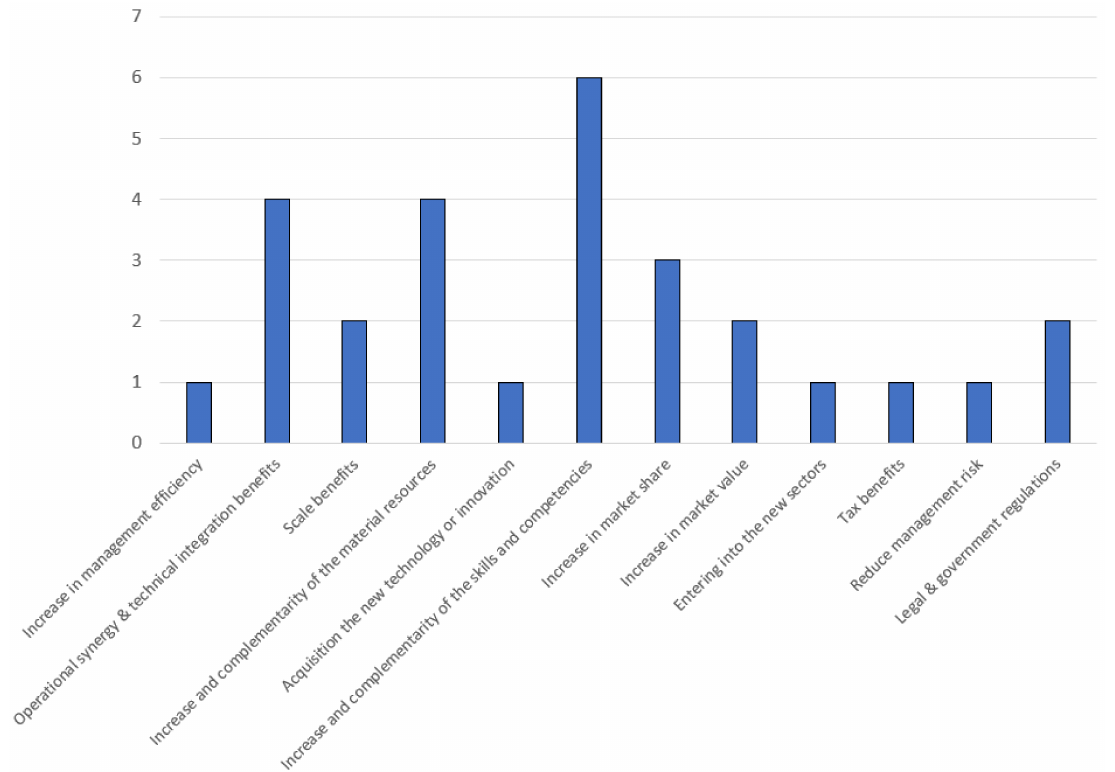
Figure 3. The frequency of occurrence of the secondary M&A motives in the transactions led by business risk diversification, conducted by public companies from the electrical energy generation sector during the period 1 January 2015–19 November 2021 in the research sample.